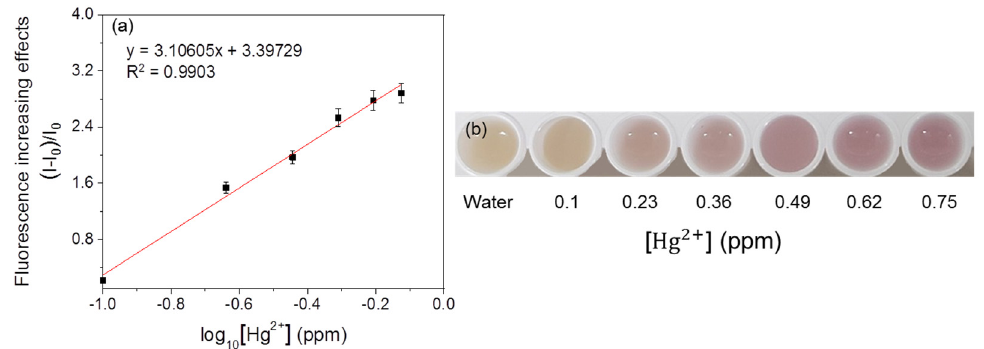
Figure 3. Concentration-dependent responses of fluorescent mercury-sensing strain with mercury. ( a ) The correlation between fluorescence increasing effects and mercury concentration of the strain. ( b ) Visual detection of mercury by the strain.